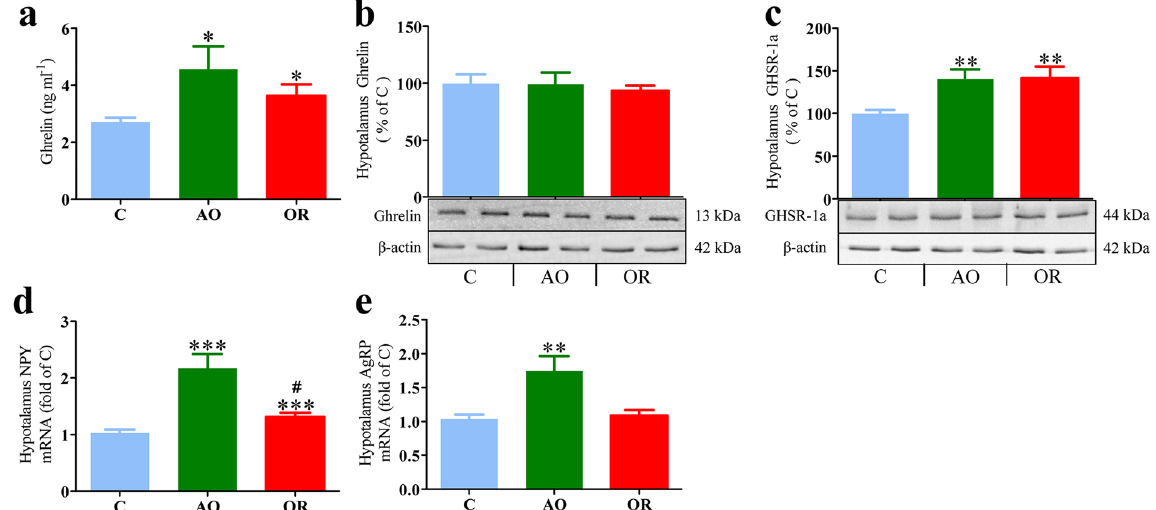
Figure 4. Plasma ghrelin and its related hypothalamic mediator factors. ( a ) Plasma ghrelin; ( b ) Representative hypothalamic ghrelin protein determined by Western blot; ( c ) Representative GHSR1 α protein determined by Western blot; ( d ) Hypothalamic NPY relative mRNA level; ( e ) Hypothalamic AgRP relative mRNA level. A densitometric analysis on separate Western immunoblot analyses summarizing the eight animals per group; AgRP – Agouti-related protein; NPY – Neuropeptide Y; GHSR1 α – GH secretagogue receptor 1 alpha. Error bars are s.e.m. Statistical differences were determined by unpaired 2-tailed t test. ** p < 0.01, difference between control group (C, blue color) and airway obstruction group (AO, green color). # p < 0.05 difference between AO and obstruction removal